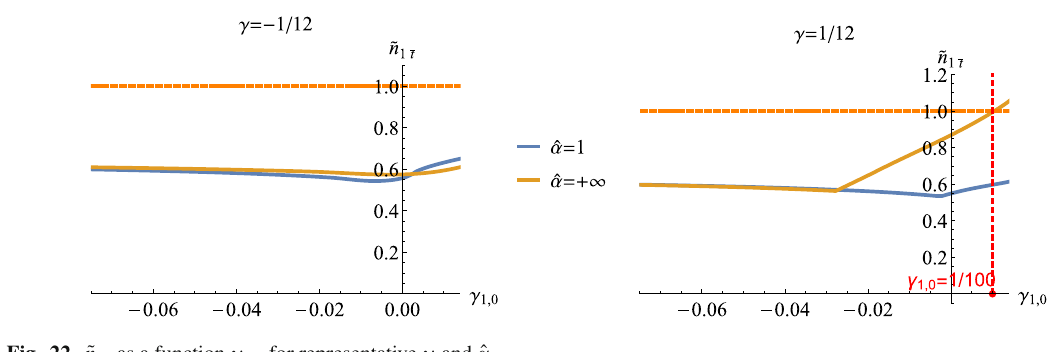
Fig. 22 ˜ n 1 ¯ t as a function γ 1 , 0 for representative γ and ˆ α